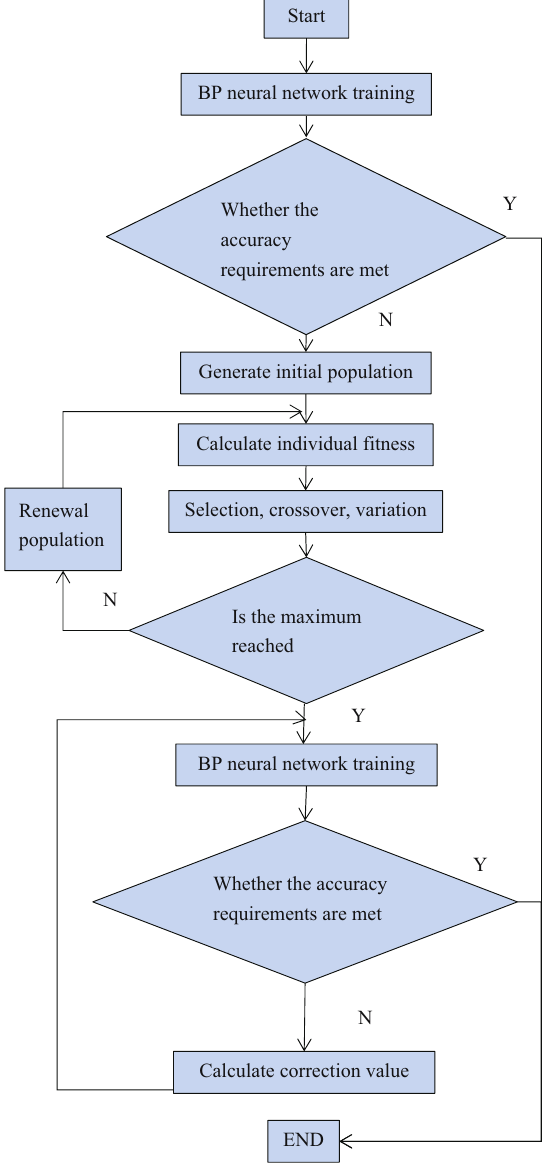
Figure 3: GA - BP network fl